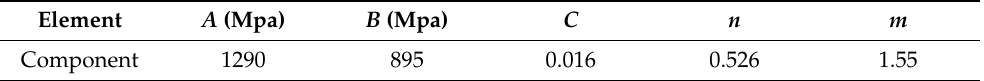
Table 1. Johnson–Cook constitutive equation parameters. Data are from